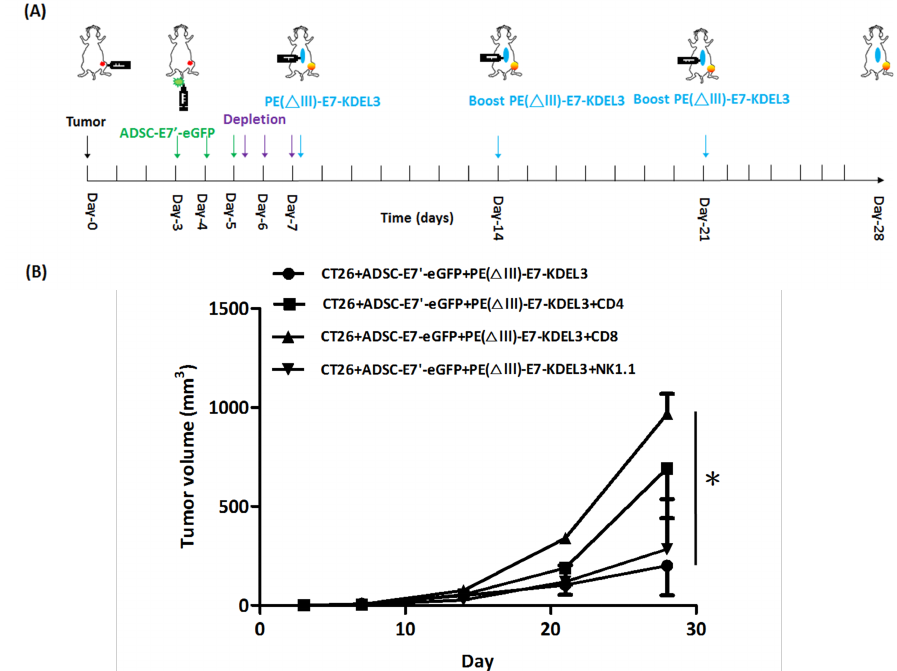
Figure 6. In vivo antibody depletion reduces the antitumor effect of the ADSC-E7’-eGFP–PE( △ III)-E7-KDEL3 combined treatment. ( A ) Time course of the experiment; ( B